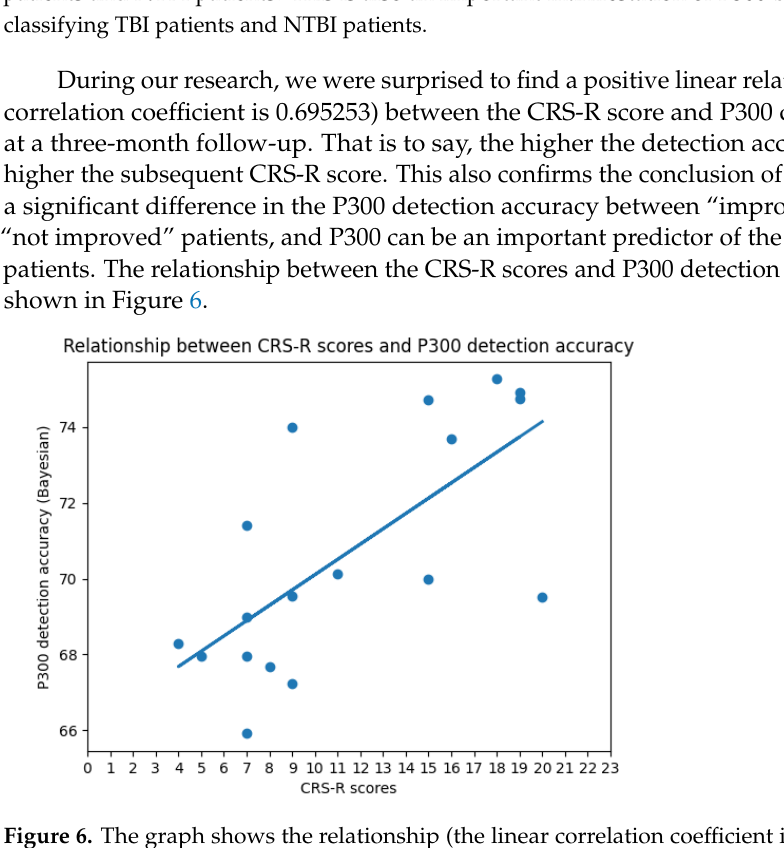
Figure 6. The graph shows the relationship (the linear correlation coefficient is 0.695253) between the CRS-R score and the accuracy of P300 detection ( CNN ) at a three-month follow-up. The hori- zontal axis is the patient’s CRS-R score, and the vertical axis is the corresponding P300 detection accuracy ( CNN